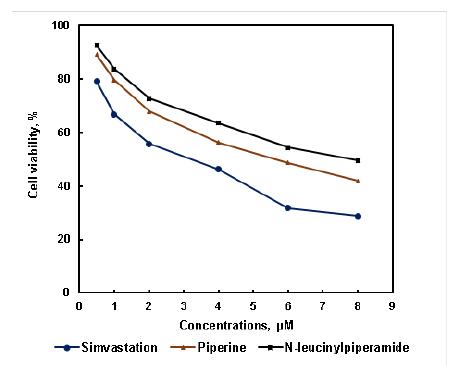
Fig. 2. The IC values of antihyperlipidemic compounds 50 with various concentrations on the cell